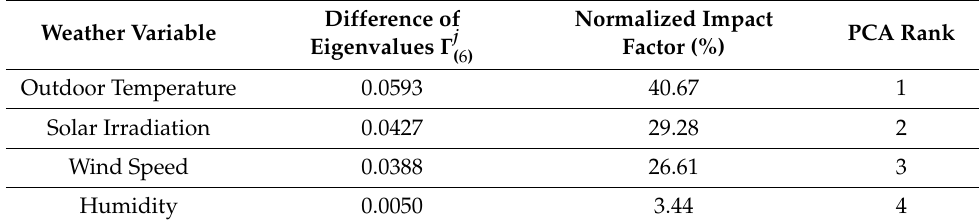
Table 2. PCA ranks for 4 weather variables.